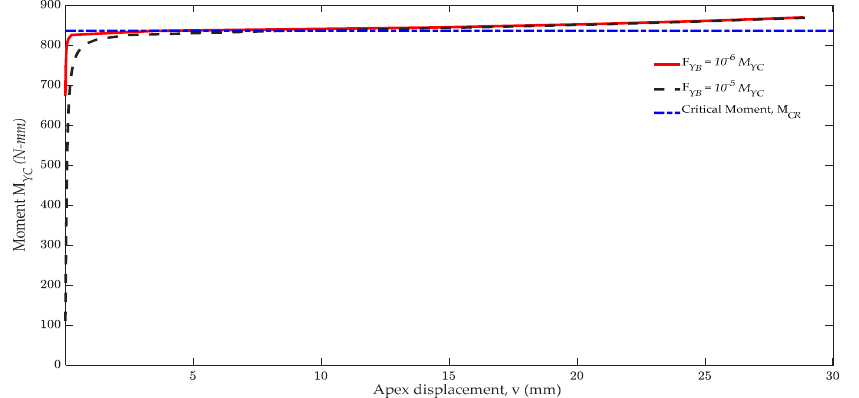
Figure 16. Curved beam subject to the end moment.